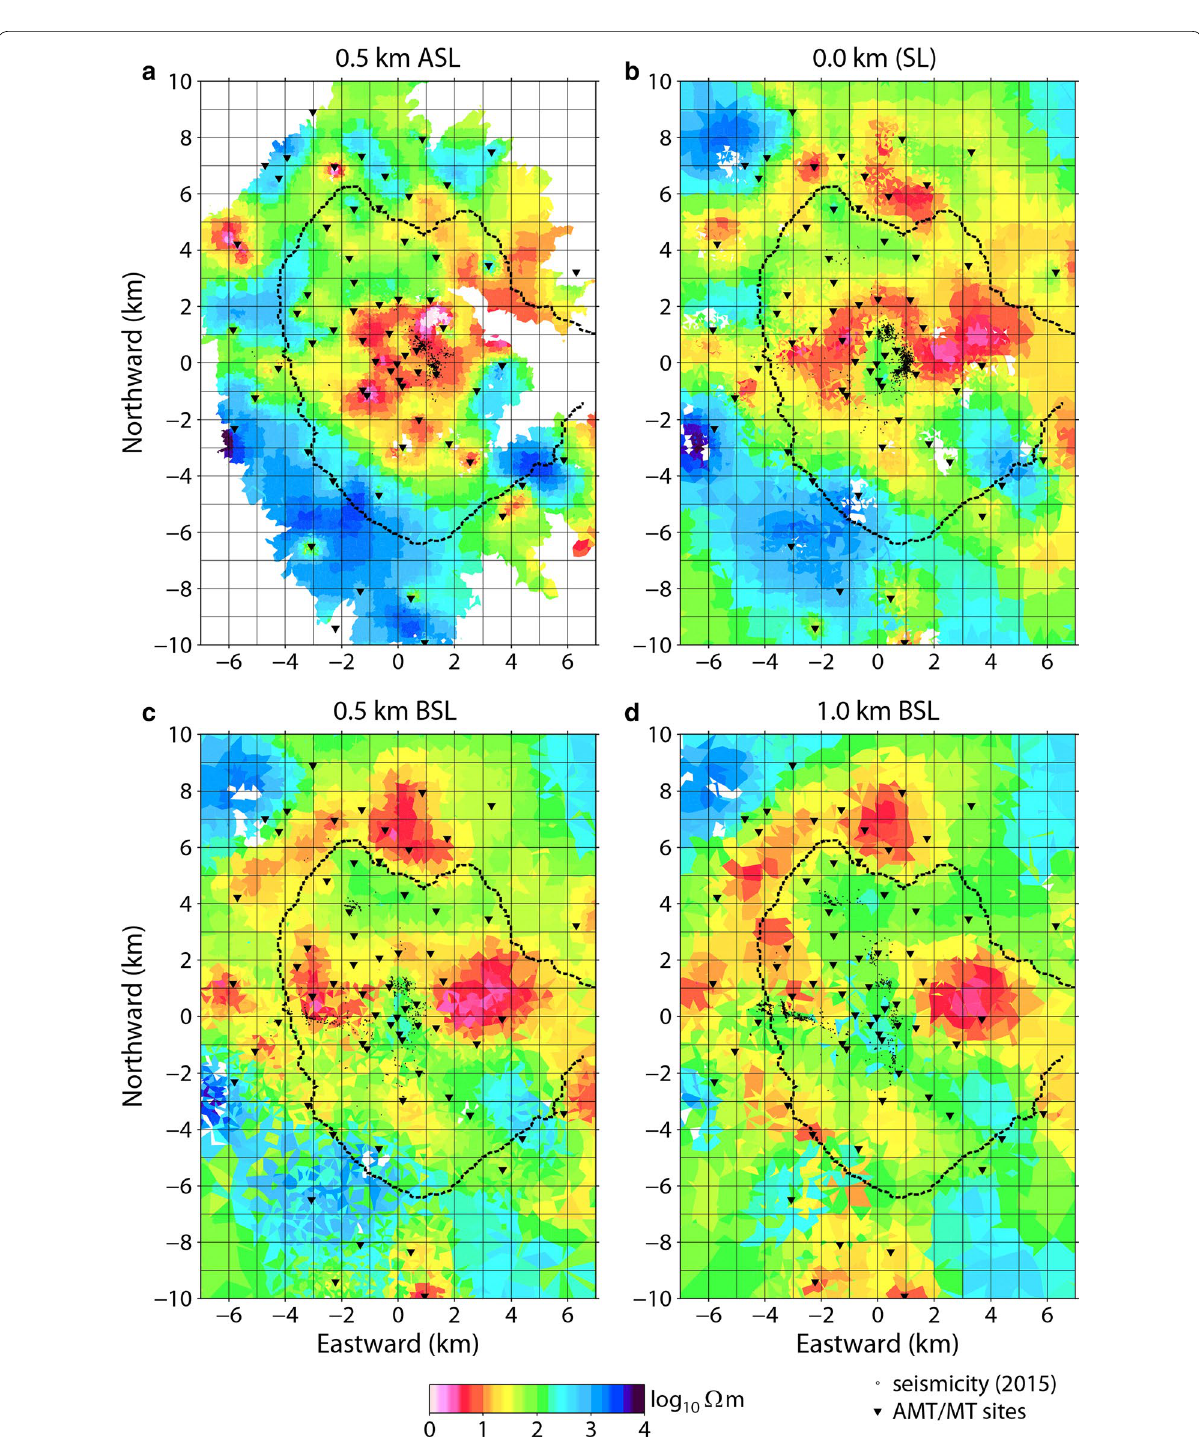
Fig. 5 Horizontal slices of the three‑dimensional resistivity structure for various depths. Visualised elements are selected in the same manner as in Fig. 4. a – d show the XY planes at z 0.5 km (0.5 km above sea level: ASL), z 0.0 km (sea level: SL), z 0.5 km (0.5 km below sea level: BSL) = − = = and z 1.0 km (1.0 km BSL), respectively. Inverted black triangles represent the locations of the AMT/WMT sites. The earthquake epicentres that = occurred within 0.125 km of the cutting‑plane are shown as black dots. The present caldera rim of Hakone volcano is indicated by the dotted ± black